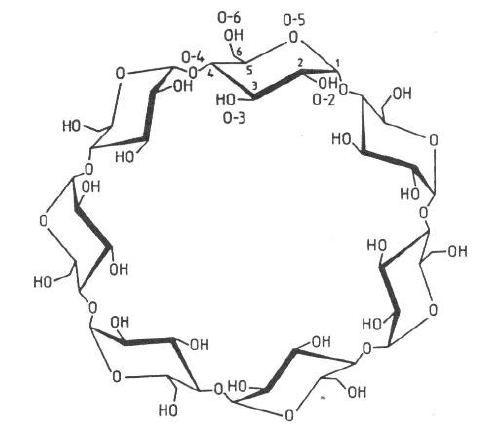
Figure 1 . Chemical structure of b -